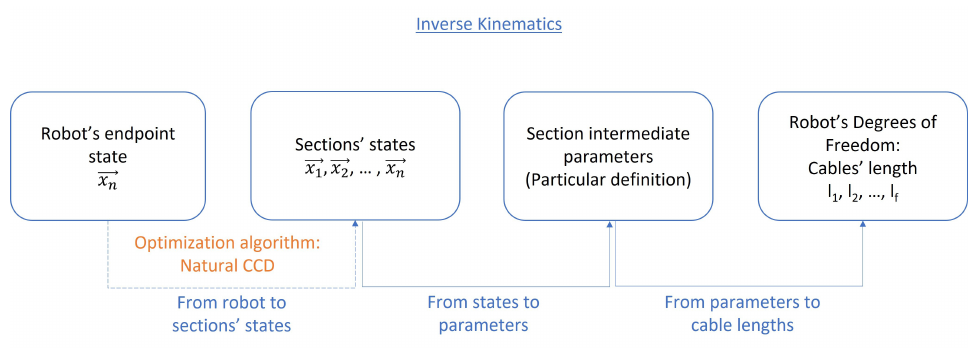
Figure 18. Inverse kinematics using